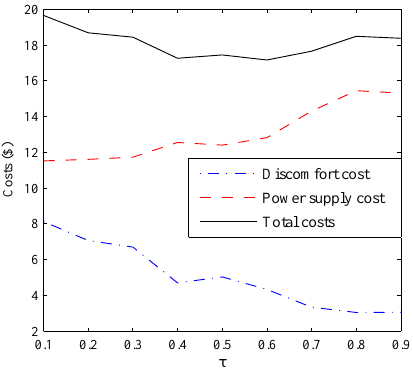
Figure 7. The impact of tradeoff factor.